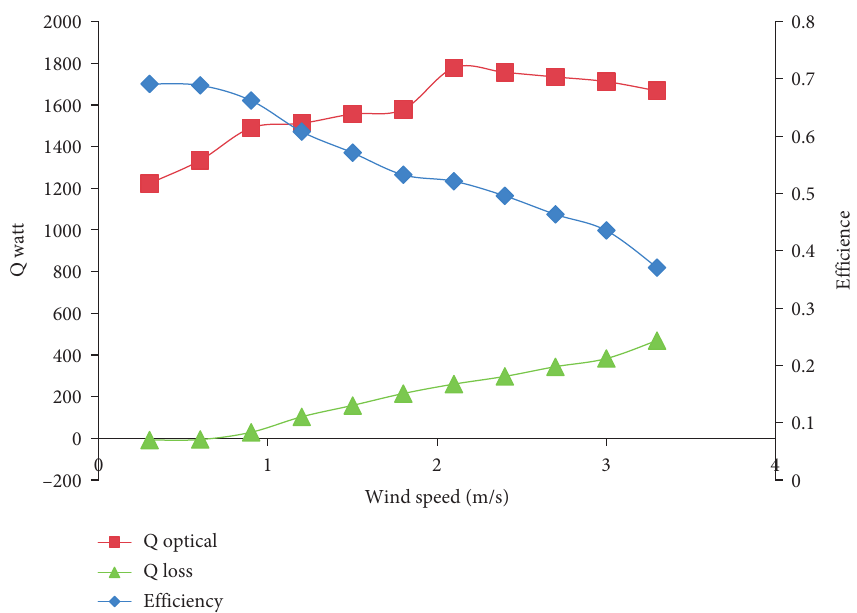
Figure 10: Relation between efficiency with wind speed.